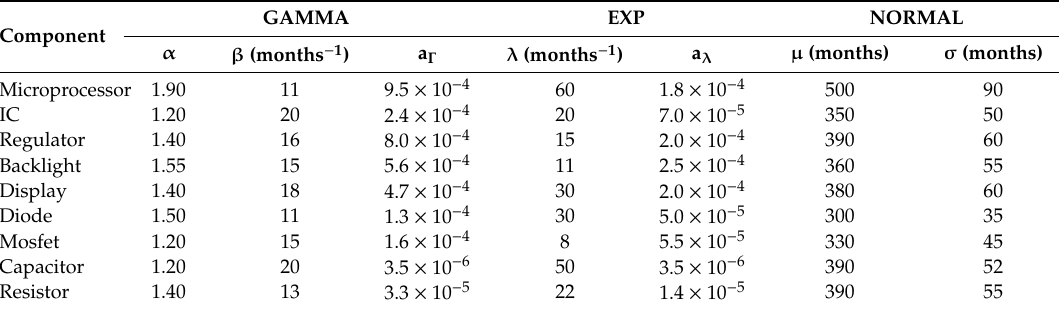
Table 1. Table of coe ffi cients of the failure